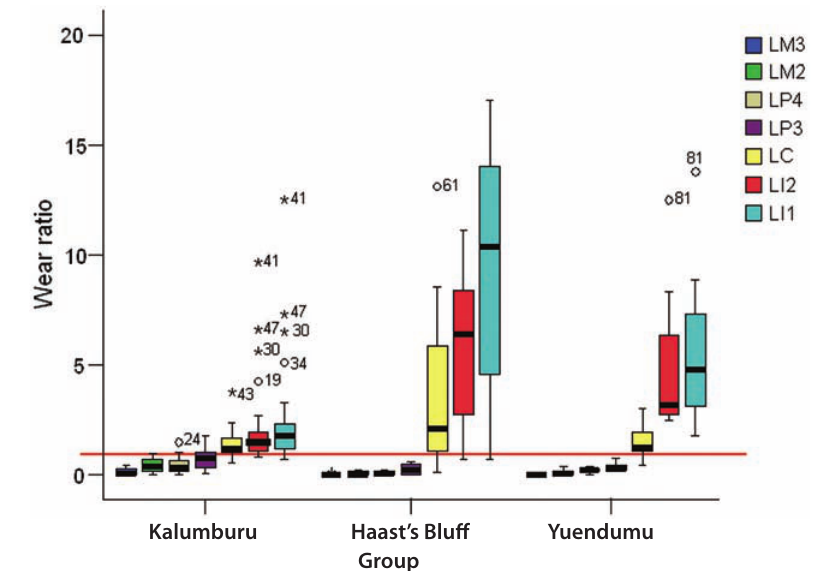
Figure 8 Graph showing the wear ratios for the lower dentition. Details as for Figure